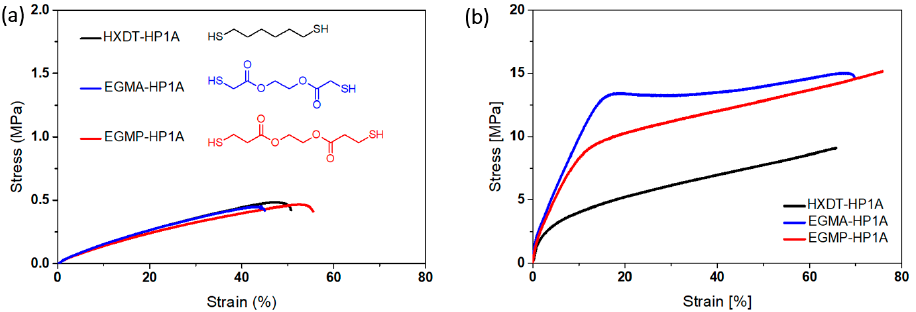
Figure 48. Mechanical properties of DLP 3D printed materials ( a ) prior to and ( b ) after thermal treatment at 180 °C for 4 h. Reproduced with permission from [101]. Copyright © 2022 Elsevier.